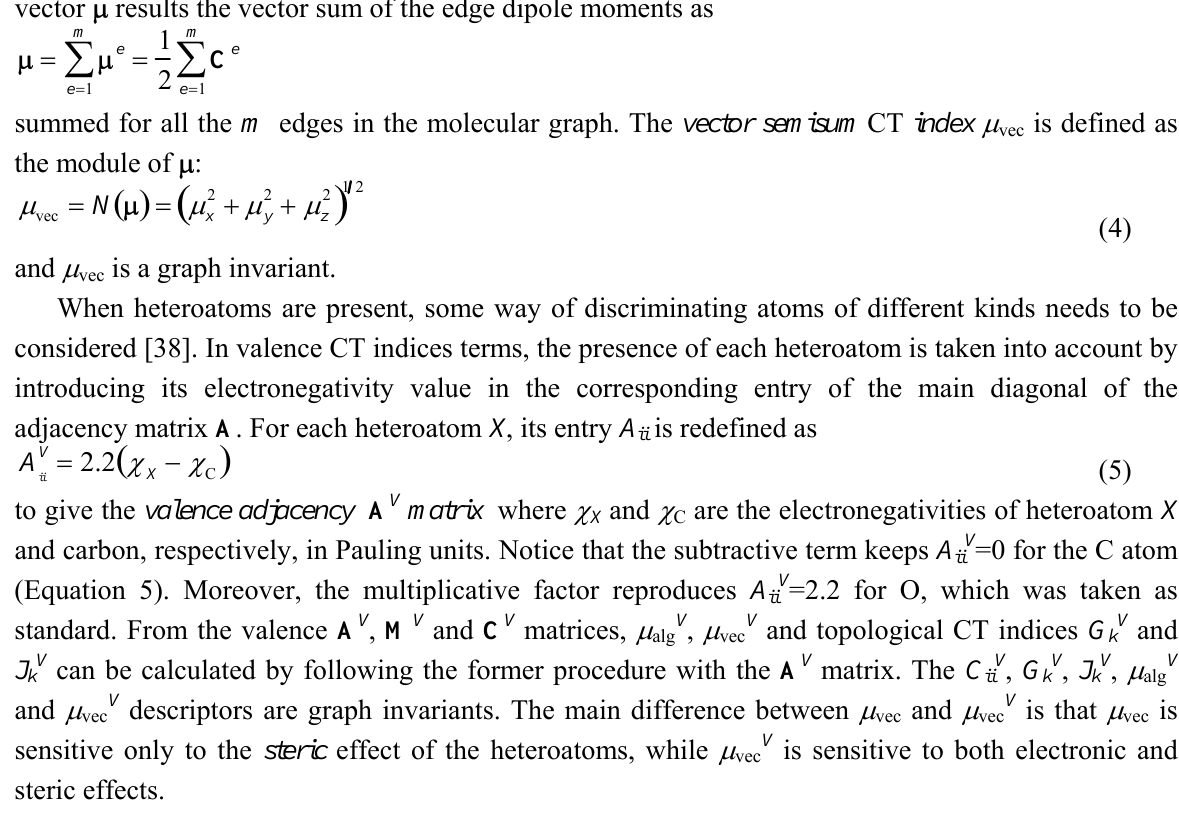
Table 1. Molecular dipole moment (in D) for hydrocarbons and ethers with charge